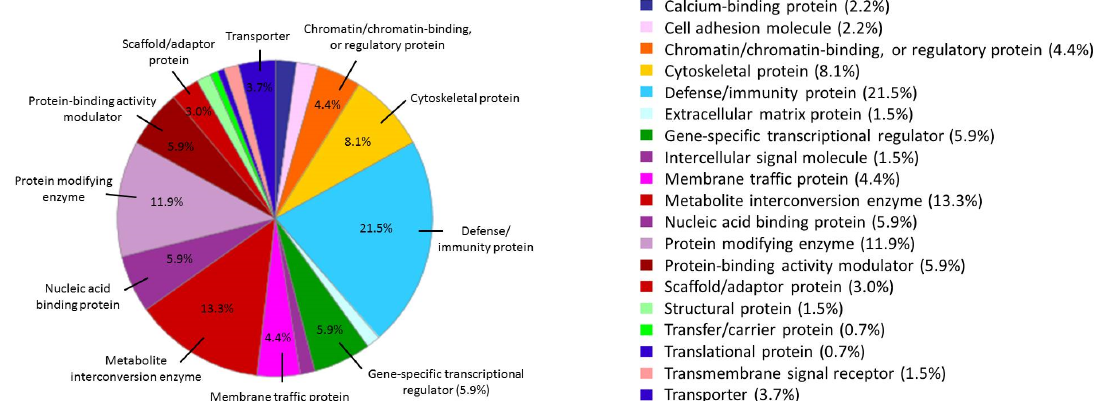
Figure 4. Functional classifications of the 194 specific proteins found in the AuNP–protein corona after the interaction of AuNPs (10.02 ± 0.91 nm) (30 min, incubation) with serum samples belonging to 42 breast cancer patients, according to their protein classes by PANTHER.